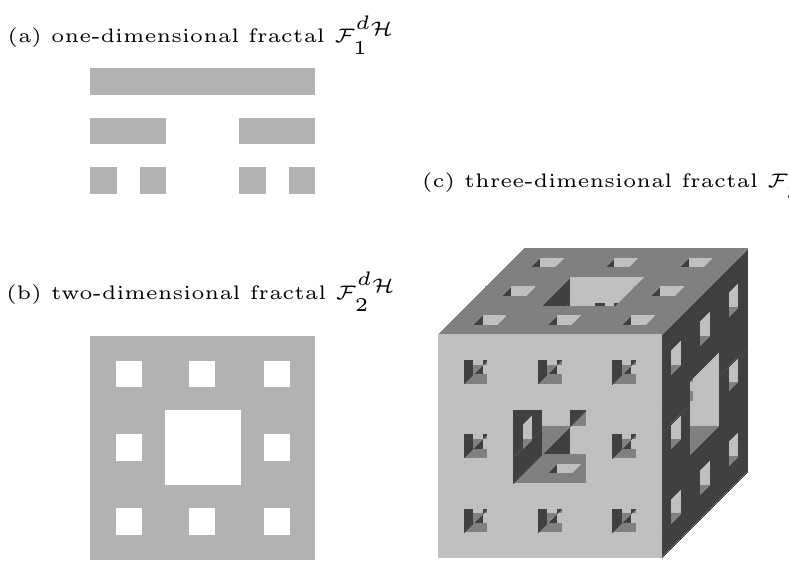
Figure 1. Construction of three-dimensional fractal Menger sponge, ( a ) The middle-1/3 Cantor set: C 1/3 ⊂ (cid:60) , ( b ) two-dimensional Cantor Set or Sierpinski carpet: S 1/3 ⊂ (cid:60) 2 , and ( c ) three-dimensional Cantor set or Menger sponge: M 1/3 ⊂ (cid:60) 3